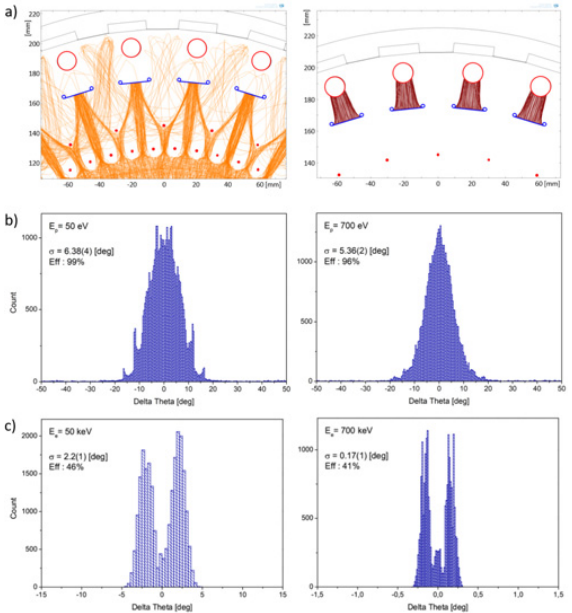
Figure 5. Row a) shows on the left panel the simulated proton tracks hitting the p − e converter foil. 50eV protons arrive from the field free region and are accelerated in the electric field of 10 kV/cm. Right panel presents the secondary electrons emitted from the p − e converter and accelerated to 30keV by electric field. Proton detectors are marked as red circles. Rows b) and c) show distributions of the deflection angle (from original direction) for protons and decay electrons, respectively. Only two cases (for boundary energies) are presented.